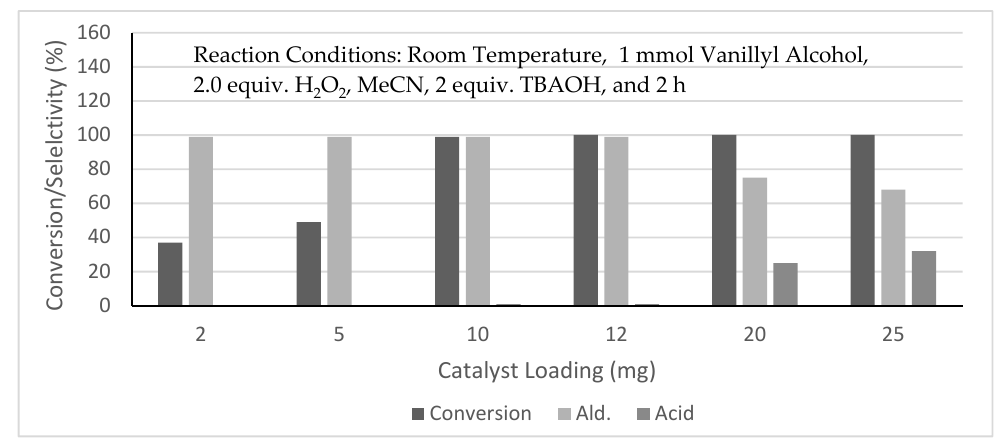
Figure 9. The effect of the ZnFe 2 O 4 -NP catalyst loading in toluene oxidation. Figure 9. The e ff ect of the ZnFe 2 O 4 -NP catalyst loading in toluene oxidation.